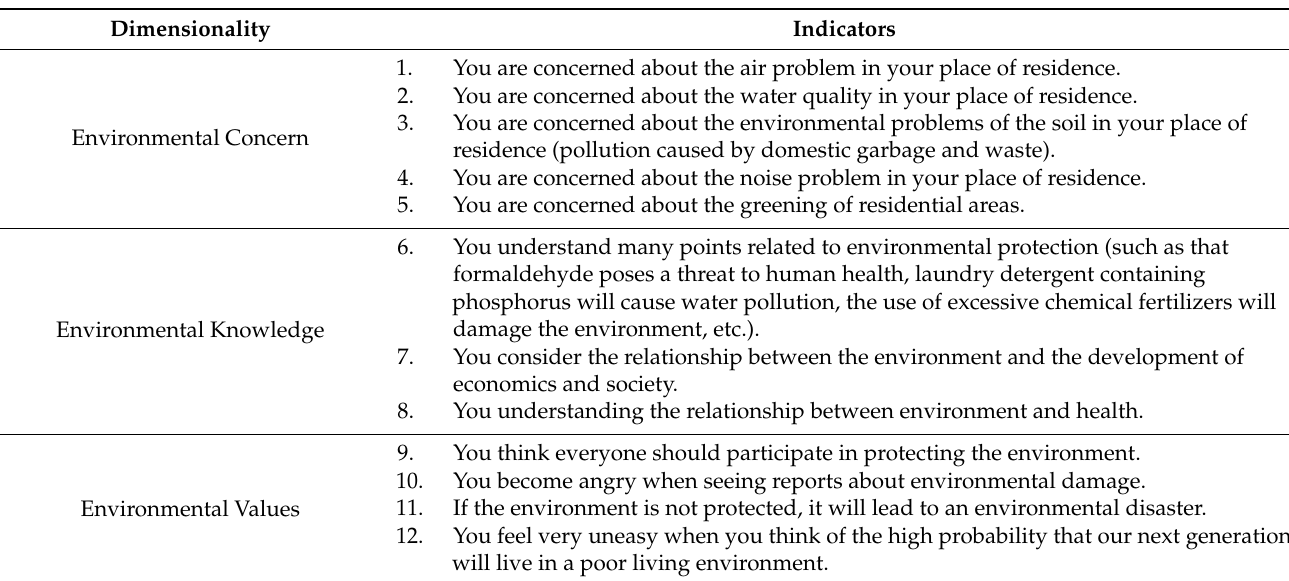
Table 1. Environmental awareness evaluation indicators.